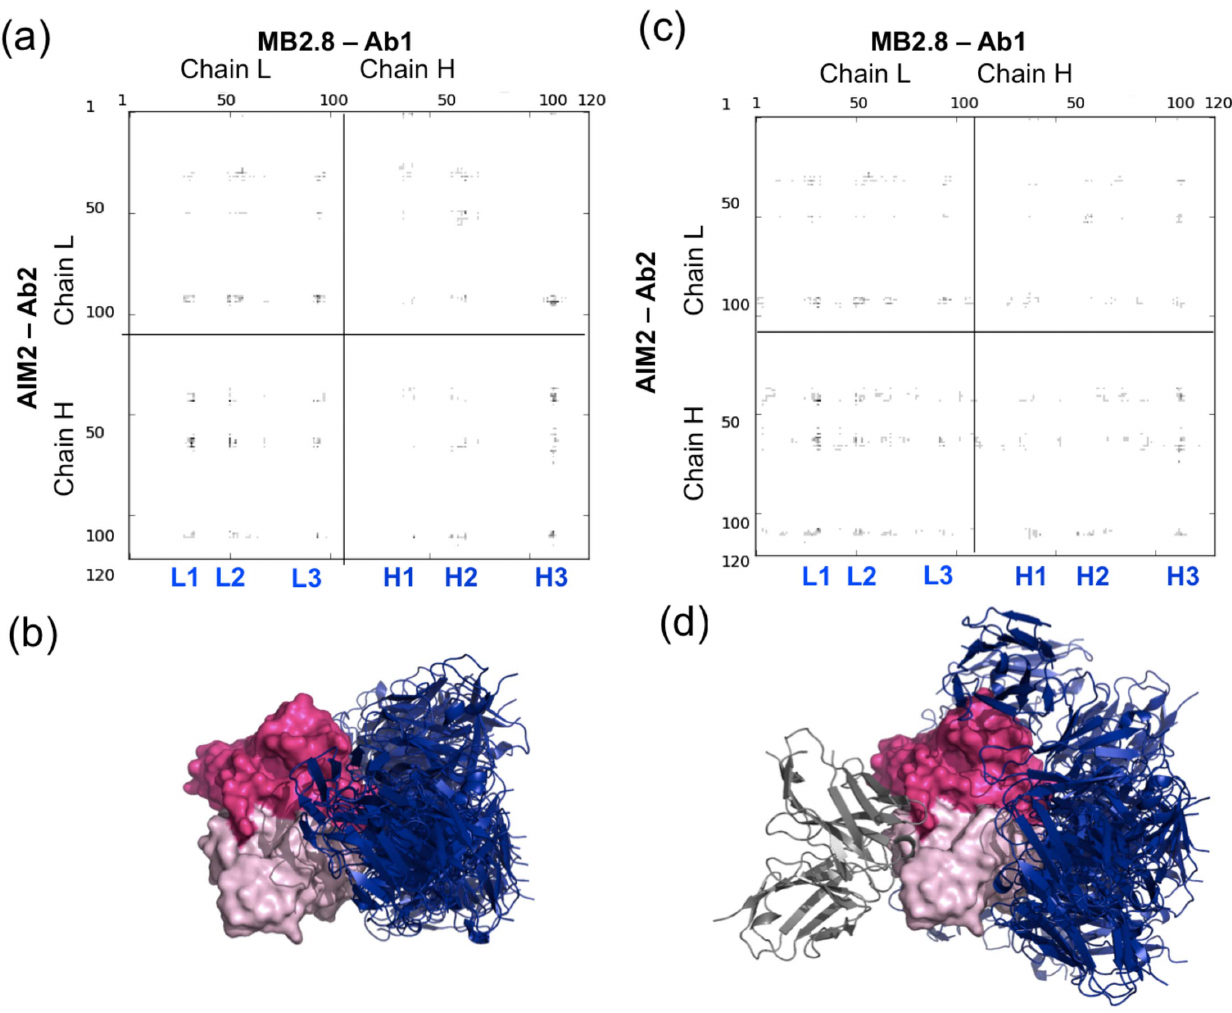
Figure 2. Comparison between the top ‘CDR-directed’ and ‘blind’ docking solutions. ( a ) and ( c ): the CONS-COCOMAPS consensus maps calculated for the 22 models from the CDR-directed docking simulations ( a ) and for the 30 models from the ‘blind’ ones ( c ). Labels have been added for the MB2.8 CDR loops L1-L3 and H1-H3. ( b ) and ( d ): Pymol [70] visualization of the representative models of the top ten clusters in both CDR- directed ( c ) and ‘blind’ docking simulations ( d ), after superimposition of Ab1-MB2.8. The MB2.8’s light chain is colored in pink, its heavy chain is colored in hotpink. All the models using the MB2.8 CDR region for the binding have AIM2 colored in blue, while AIM2 is colored in silver in the 7 th solution of the blind simulation.